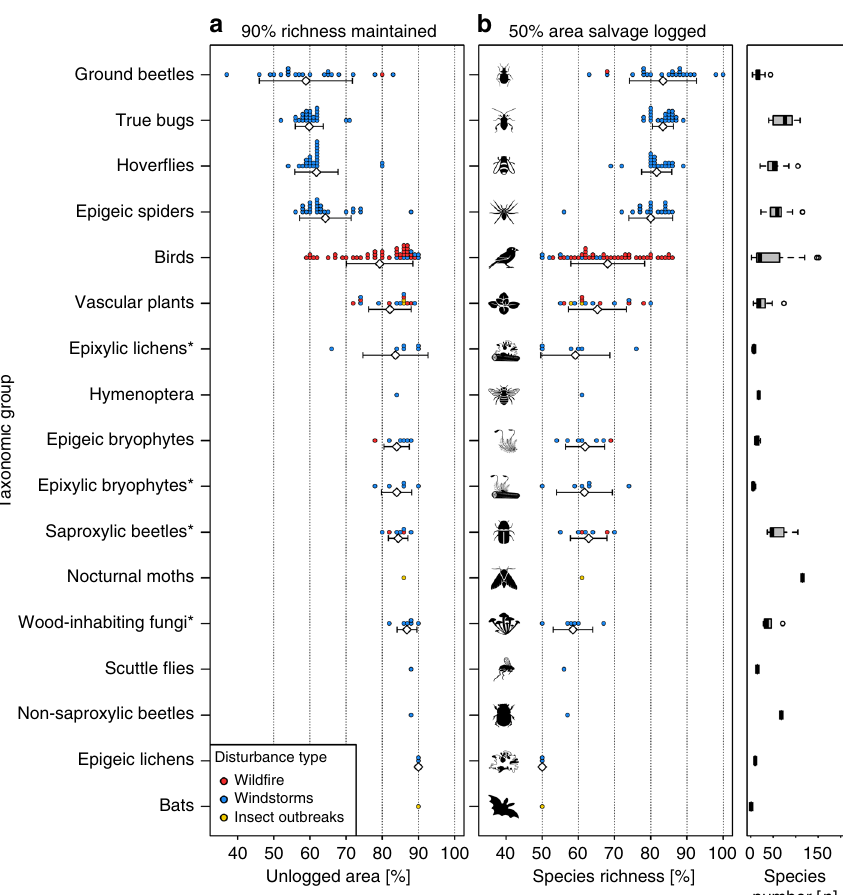
Fig. 4 Estimated retention benchmarks for the assessed taxonomic groups. Distribution (dot histogram) and mean values (white diamonds) with corresponding standard deviation for: ( a ) the retention area needed to maintain 90% of species unique to unlogged naturally disturbed forest; and ( b ) the portion of species unique to unlogged naturally disturbed forest that would be maintained if 50% of the disturbed area was salvage logged. Saproxylic groups are marked with an asterisk. The right-hand box-whisker plots depict the median number of species unique to unlogged naturally disturbed plots (see Supplementary Table 1 for details) with lower and upper quartiles (box). Icons with permission from thenounproject.com. Source data are provided as a Source Data fi